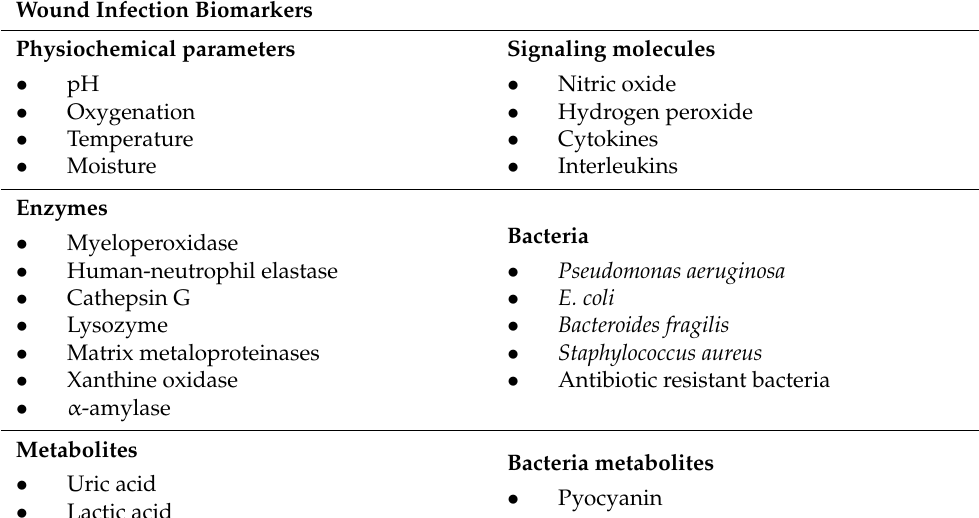
Table 1. Examples of biomarkers for wound infection diagnosis. Adapted from References